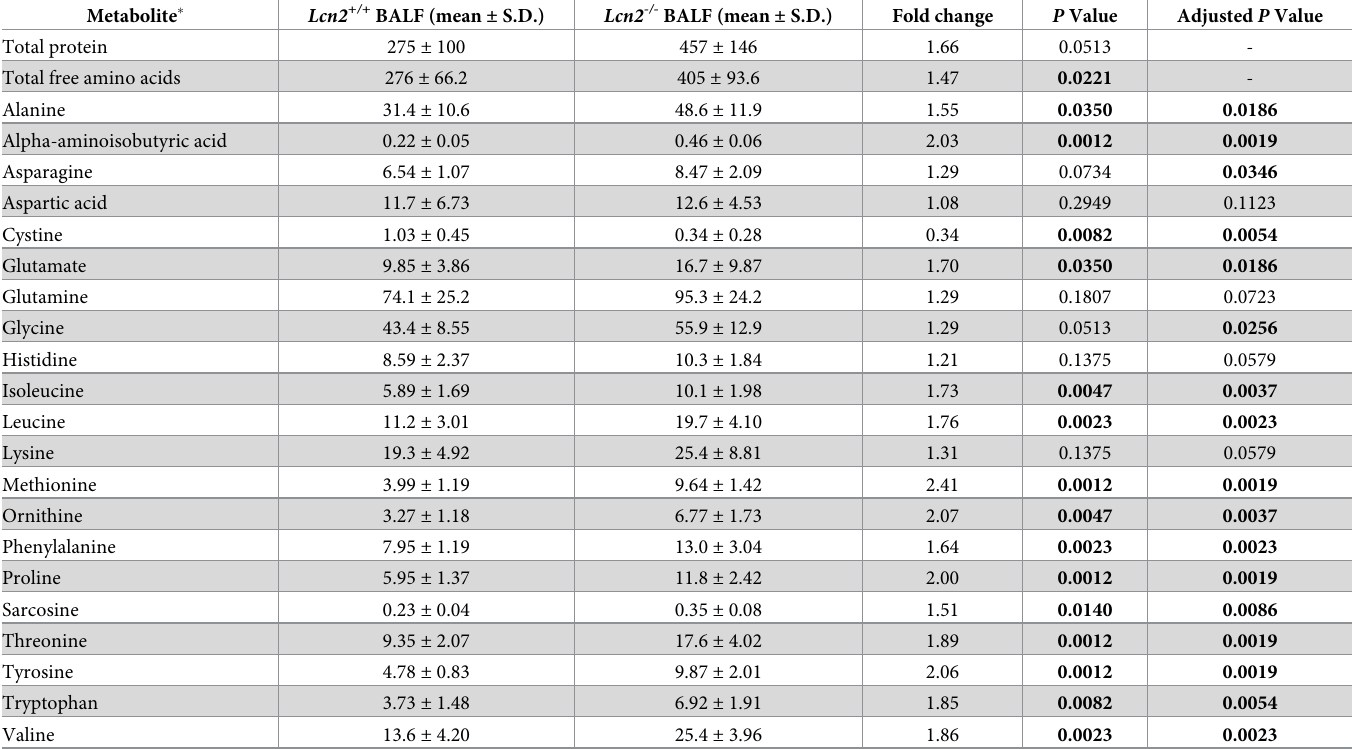
Table 2. Summary of amino acid and protein quantification from Lcn2 +/+ and Lcn2 -/- BALF. Metabolite